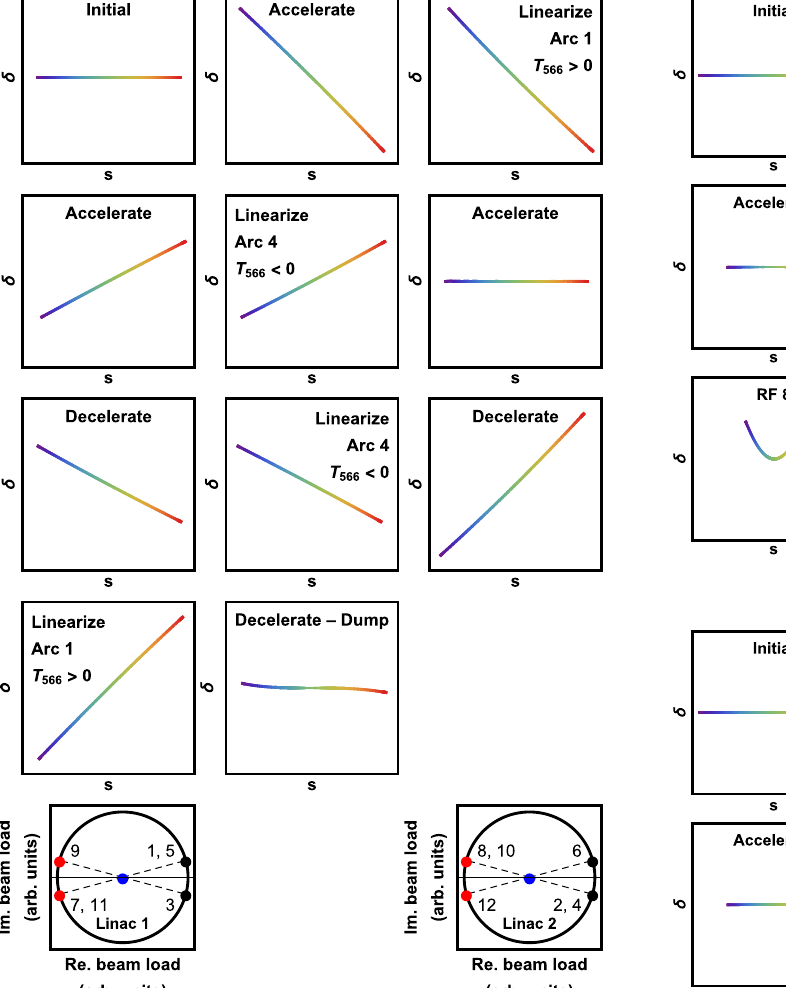
FIG. 7. Energy spread minimization with common transport. Sequence of longitudinal phase space manipulations with two linearizing arcs with opposite sign of T 566 . Beam load plots for the two linacs are shown underneath with labels indicating the order of each of the rf passes during acceleration (black), deceleration (red), and resulting beam load (blue) of each linac independently.